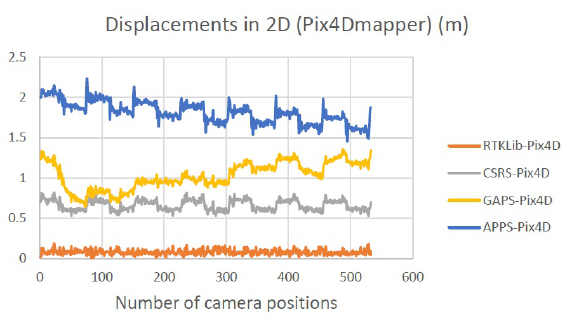
Fig. 14. Displacements in 2D between the coordinates produced by Pix4Dmapper and the software utilized in this project.